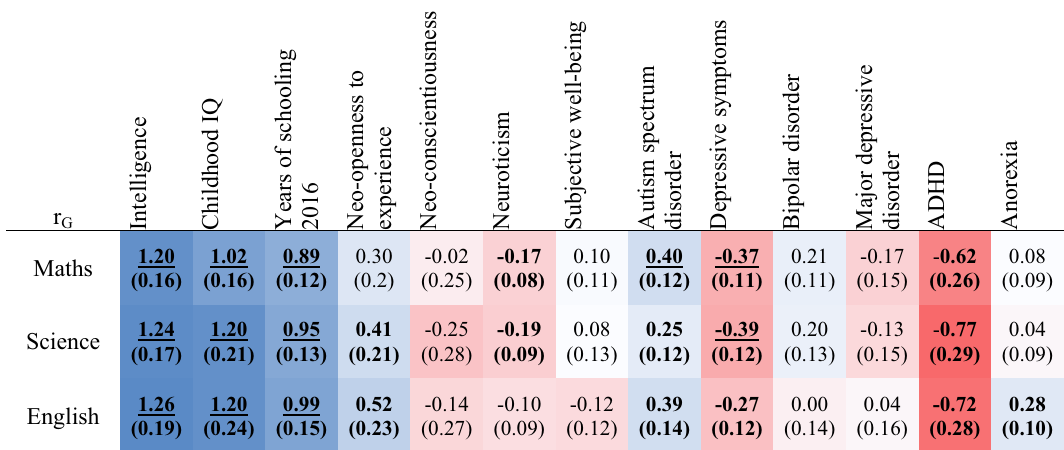
Table 6. LDSC-based genetic correlations between English, maths and science and 13 related educational and psychological traits. See Supplementary Table S8 for more details. Bolded correlation coefficients are significant p < 0.05 (uncorrected). Underlined are significant after Bonferroni correction p ≤ 0.001 (0.05/39). Red cells represent negative correlations and blue cells positive correlations. Intercepts were not constrained in any of these analyses. Statistical differences in correlation coefficients between academic subjects and a given trait were tested with a z-test; none of the correlations were significantly different from one another. Estimates > 1 are not uncommon in LDSC regression particularly if there is some sample overlap and suggests that the estimation is close to 1 with